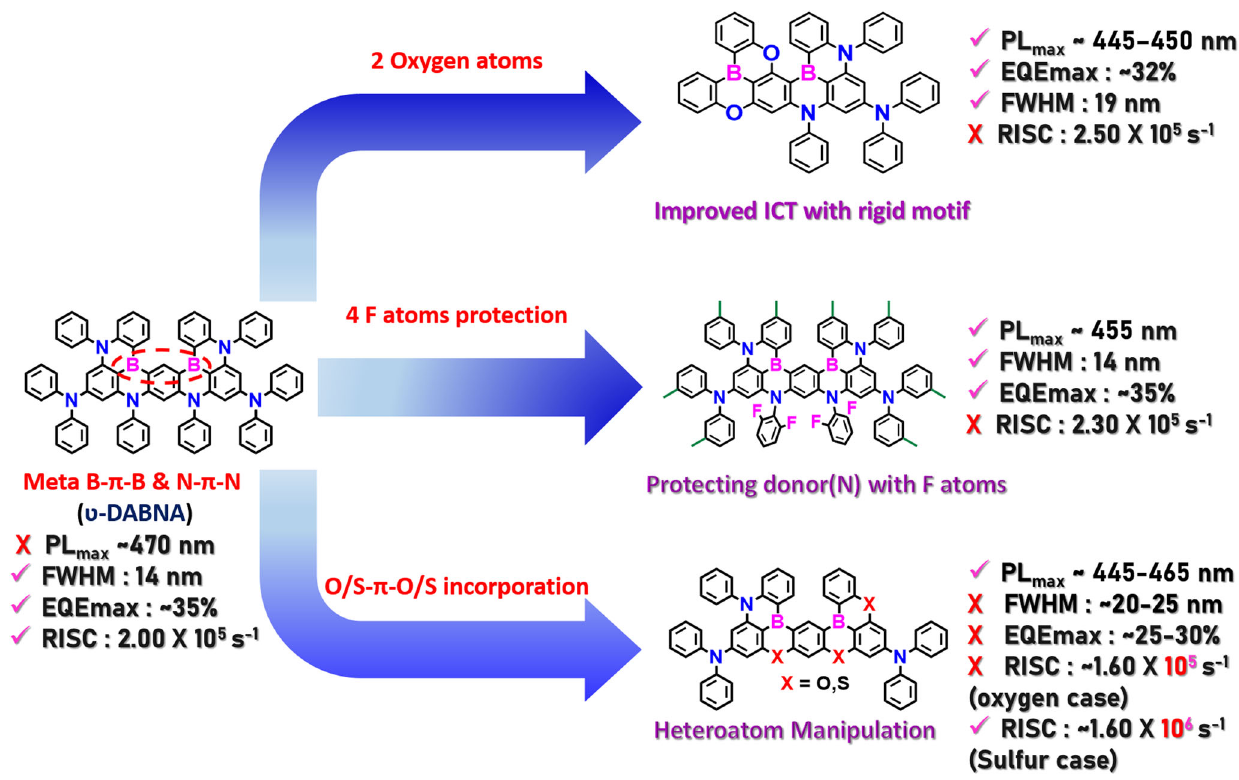
Fig. 3 Pure blue DB-MR-TADF design approaches. The design strategies for hypsochromic shift without compromising the color purity in ν -DABNA style DB-MR-TADF